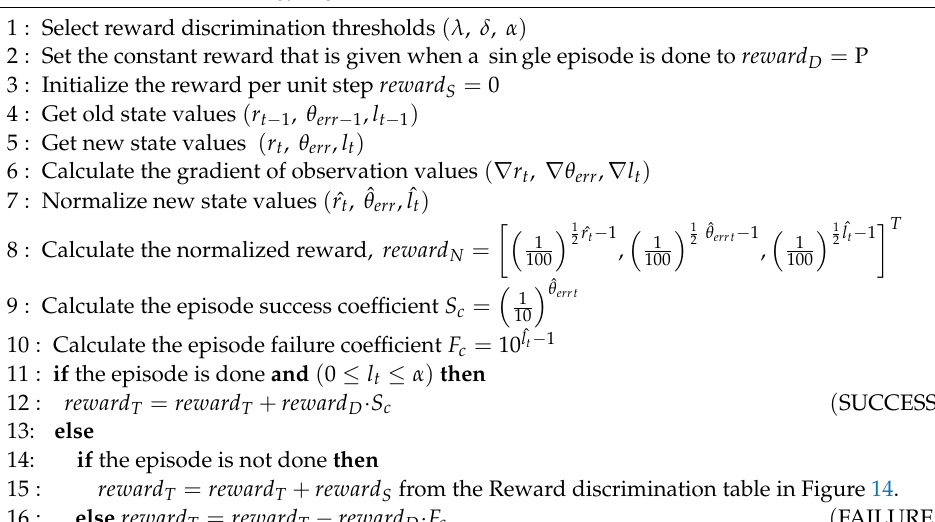
Algorithm 1 Reward strategy algorithm